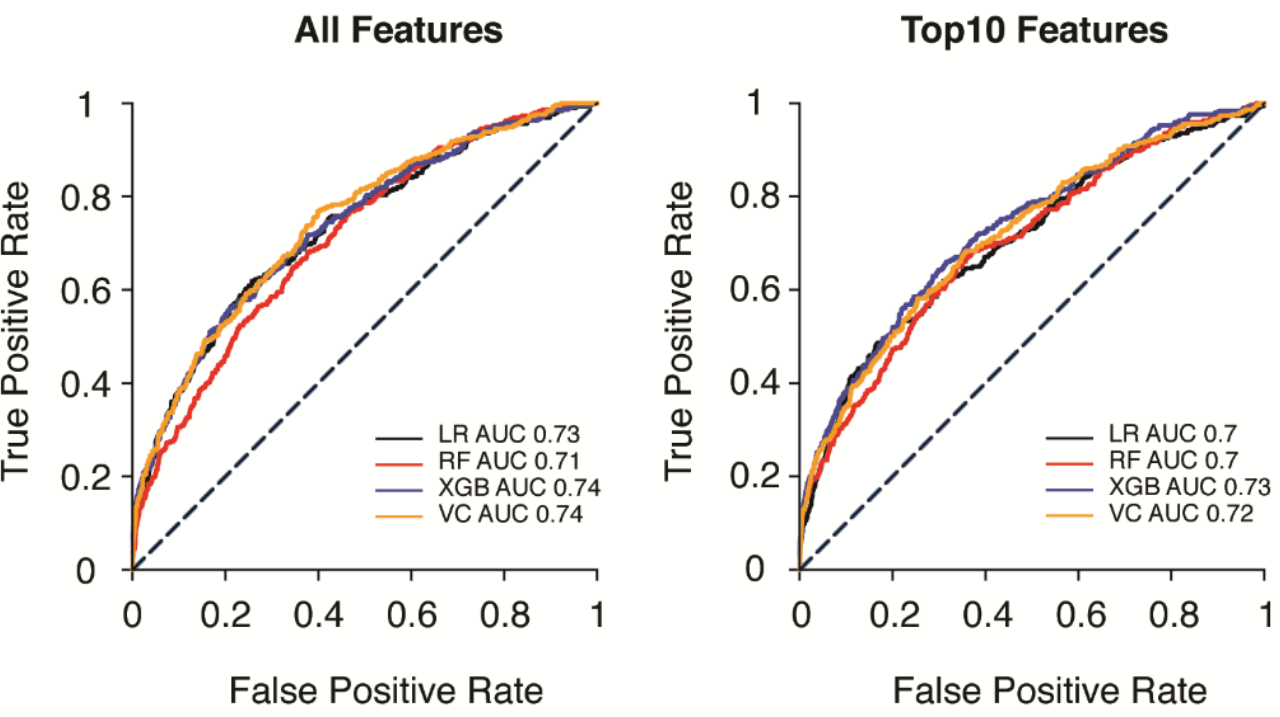
Figure 4. Comparisons of performance (AUC) for different models in predicting unscheduled emer- gency department revisits within 72 h of discharge: ( left ) prediction made by using all collected features; ( right ) the same prediction made using only the top 10 features from each model (ranked by importance).